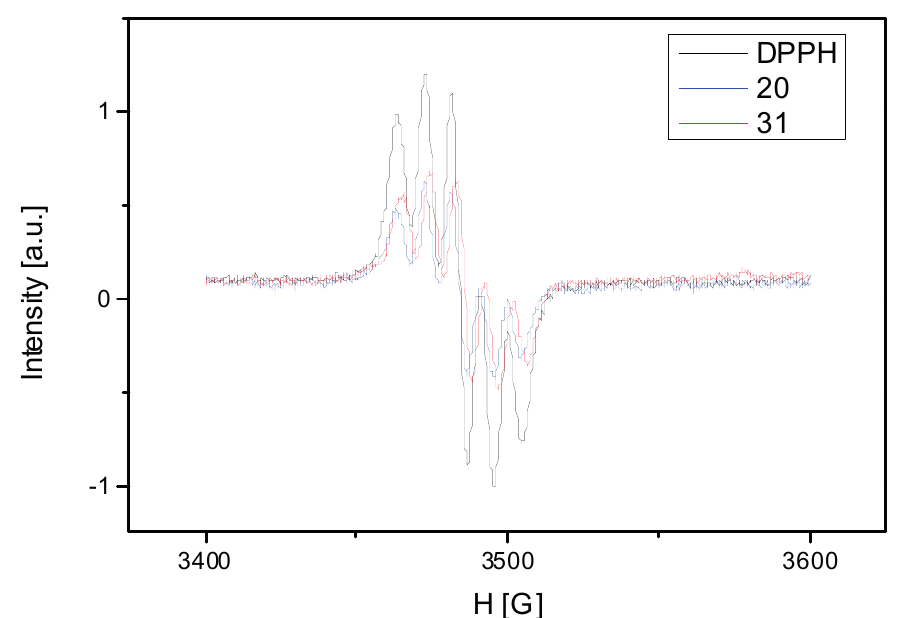
Figure 4. The rate of reaction between antioxidant compounds and DPPH radical.